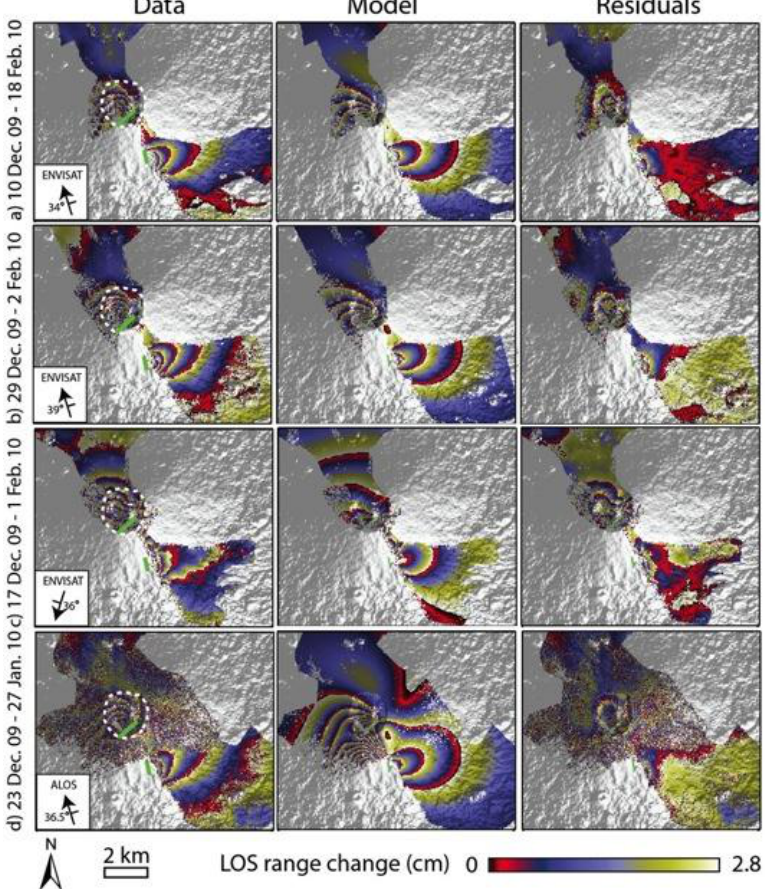
Figure 2. Data, 1st column: most coherent wrapped interferograms covering the entire 2010 Nyamulagira eruption (heights of ambiguity, i.e. , the topographic altitude difference, which generates one residual topographic fringe in a differential interferogram [14]; for interferograms, ( a )–( d ) are 45, 430, 704 and 3000 m, respectively). Pixels with coherence lower than 0.2 have been masked out (the unmasked wrapped interferograms are shown in Figure S1, and the four selected unwrapped interferograms are shown in Figure S2). Nyamulagira’s summit caldera is outlined with a dashed white line. Note that the ALOS interferogram has been rewrapped to the ENVISAT’s wavelength of 5.6 cm. Model, 2nd column, and residuals, 3rd column, for the preferred best-fit model (Figure 3), including two dike intrusions associated with the 2010 eruptive fissures (bold green lines) and a deflating reservoir, for the four interferograms ( a )–( d